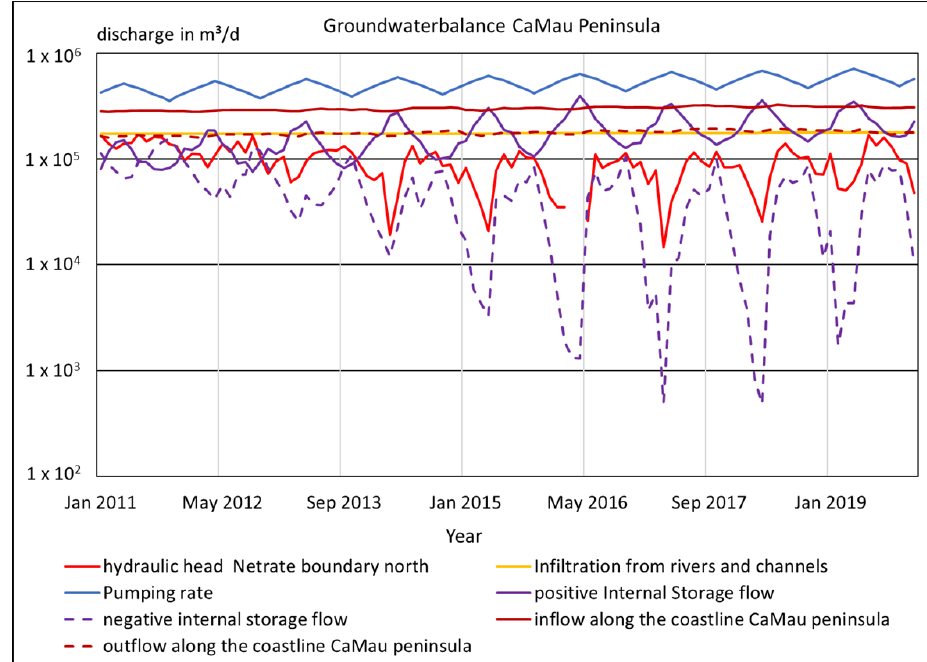
Figure 12. Groundwater balance of the model (monthly variation).